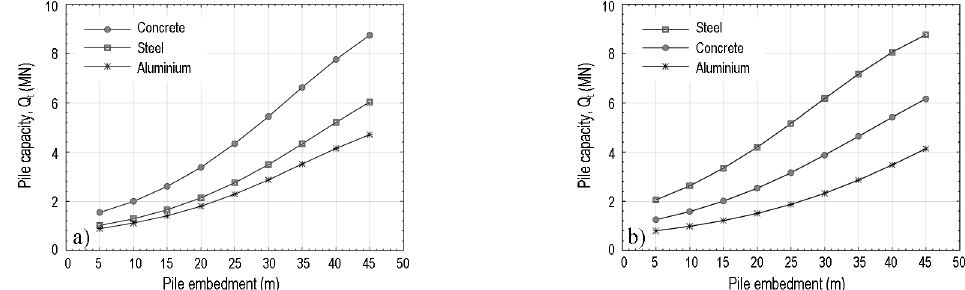
Fig. 13. Effect of pile embedment on pile capacity: (a) Large-displacement pile, (b) Low-displacement pile